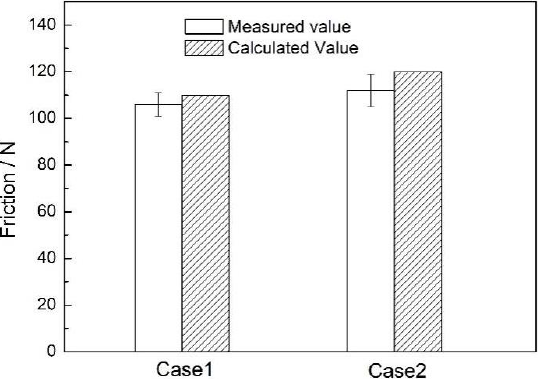
Figure 5. Comparison of the calculated average friction and the measured average friction.